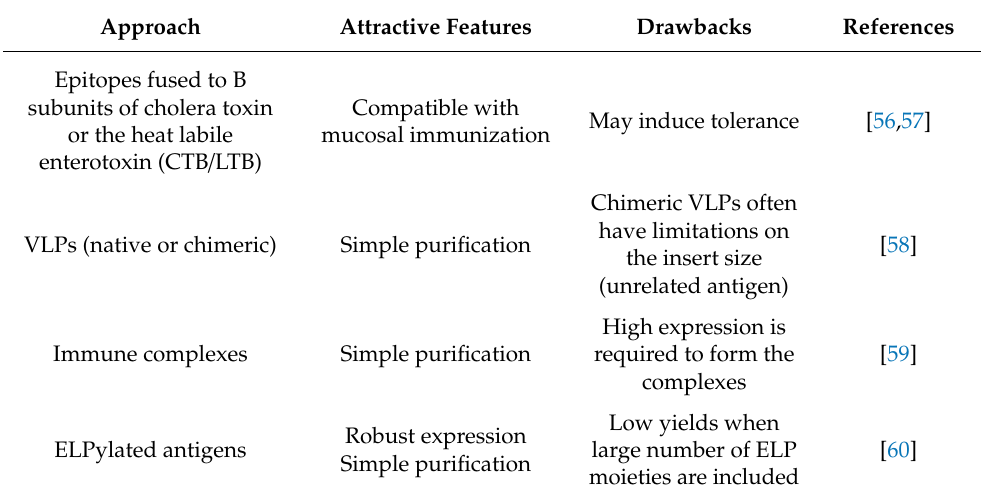
Figure 2. Developmental paths for plant-based vaccines. Vaccine antigens can comprise full length viral proteins or chimeric proteins rationally designed to serve as multiepitopic vaccines. This is based on the selection of T cell and B cell epitopes with the aid of immune bioinformatics tools and experimental data of their protective capacity. Current genetic engineering technologies allow expressing target antigens either stably or transiently, which allow exploring distinct immunization approaches. Transient expression typically requires purification of the antigen—which is useful for the formulation of injectable vaccines—whereas stable transformation, especially in edible crops, allows implementing oral immunization schemes without purification. Combined schemes, using pure antigens for priming by parenteral administration and plant biomass containing the antigen for oral boosting, are likely ideal approaches capable of inducing long-term protection in several compartments, especially in mucous membranes. Table 3. Summary of antigen design strategies rendering highly immunogenic formulations.